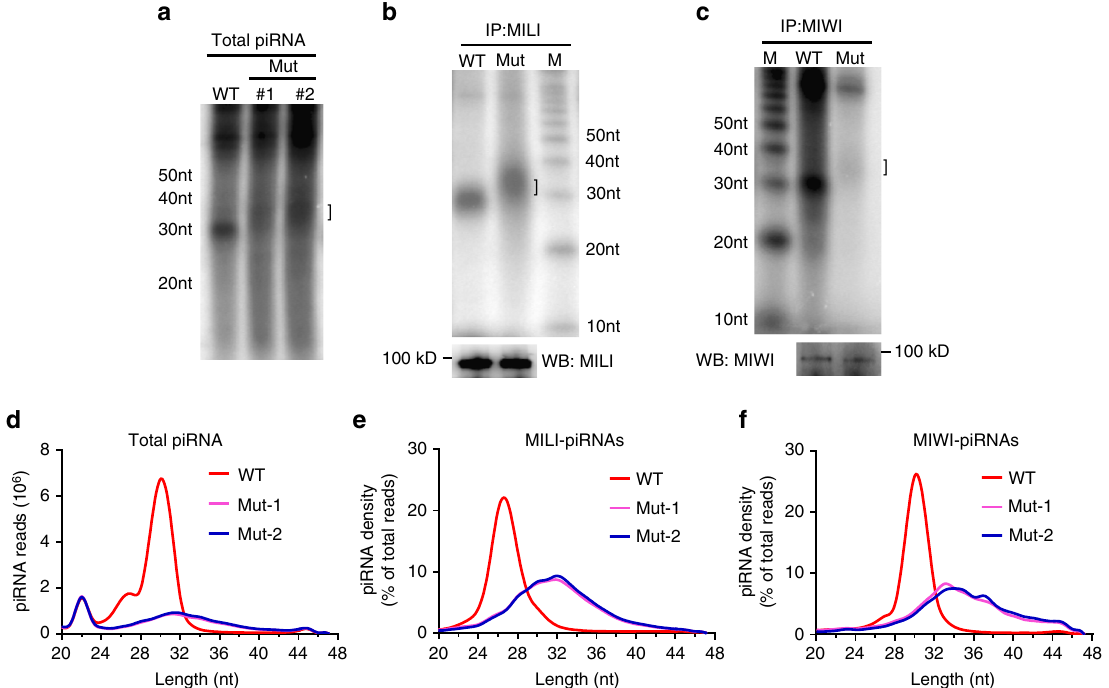
Fig. 4 Increased piRNA sizes and reduced normal piRNAs in adult Pnldc1 Mut testes. a piRNA extension in Pnldc1 Mut mice. Total RNAs from adult WT and Pnldc1 Mut (Mut-1 and Mut-2) testes were end-labeled with [ 32 P]-ATP, and detected by 15% TBE urea gel and autoradiography. Square bracket indicates extended piRNAs. b MILI-piRNA extension in Pnldc1 Mut (Mut-1) mice. Small RNAs were isolated from immunoprecipitated MILI RNPs and were end-labeled with [ 32 P]-ATP, and detected by 15% TBE urea gel and autoradiography. Western blotting was performed with anti-MILI antibody to show immunoprecipitation ef fi ciency. Square bracket indicates extended piRNAs. M molecular weight marker. c MIWI-piRNA extension and reduction in Pnldc1 Mut (Mut-1) mice. Small RNAs were isolated from immunoprecipitated MIWI RNPs and were end-labeled with [ 32 P]-ATP, and detected by 15% TBE urea gel and autoradiography. Western blotting was performed with anti-MIWI antibody to show immunoprecipitation ef fi ciency. Square bracket indicates extended piRNAs. M molecular weight marker. d The length distribution of small RNAs from adult WT and Pnldc1 Mut (Mut-1 and Mut-2) testicular small RNA libraries. Data were normalized by microRNA reads (21 – 23 nt). e The length distribution of MILI-piRNAs from adult WT and Pnldc1 Mut (Mut-1 and Mut-2) MILI-piRNA libraries. f The length distribution of MIWI-piRNAs from adult WT and Pnldc1 Mut (Mut-1 and Mut-2) MIWI-piRNA